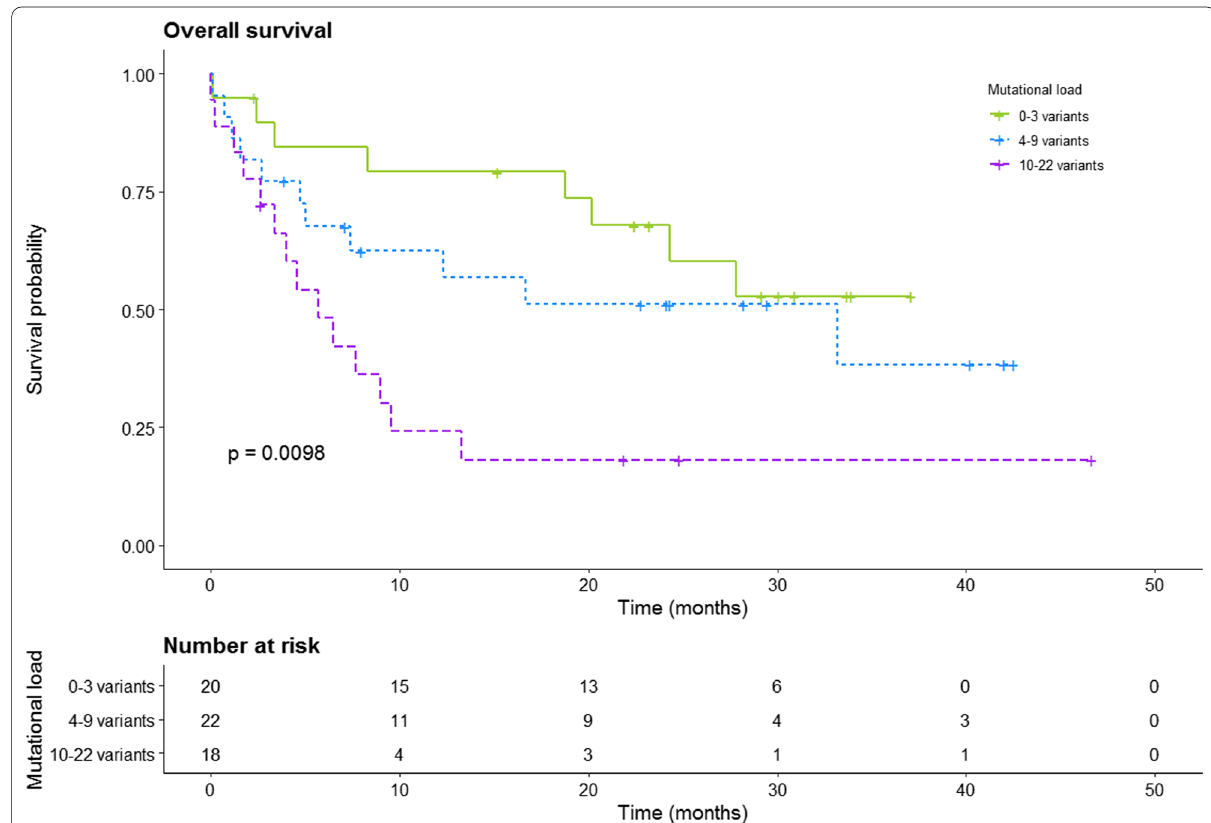
Fig. 4 Overall survival rate of lung cancer patients stratified by number of variants in plasma. Patients were divided into groups based on number of variants 0–3 variants (n 20), 4–9 variants (n 23), and 10–22 variants (n = = =